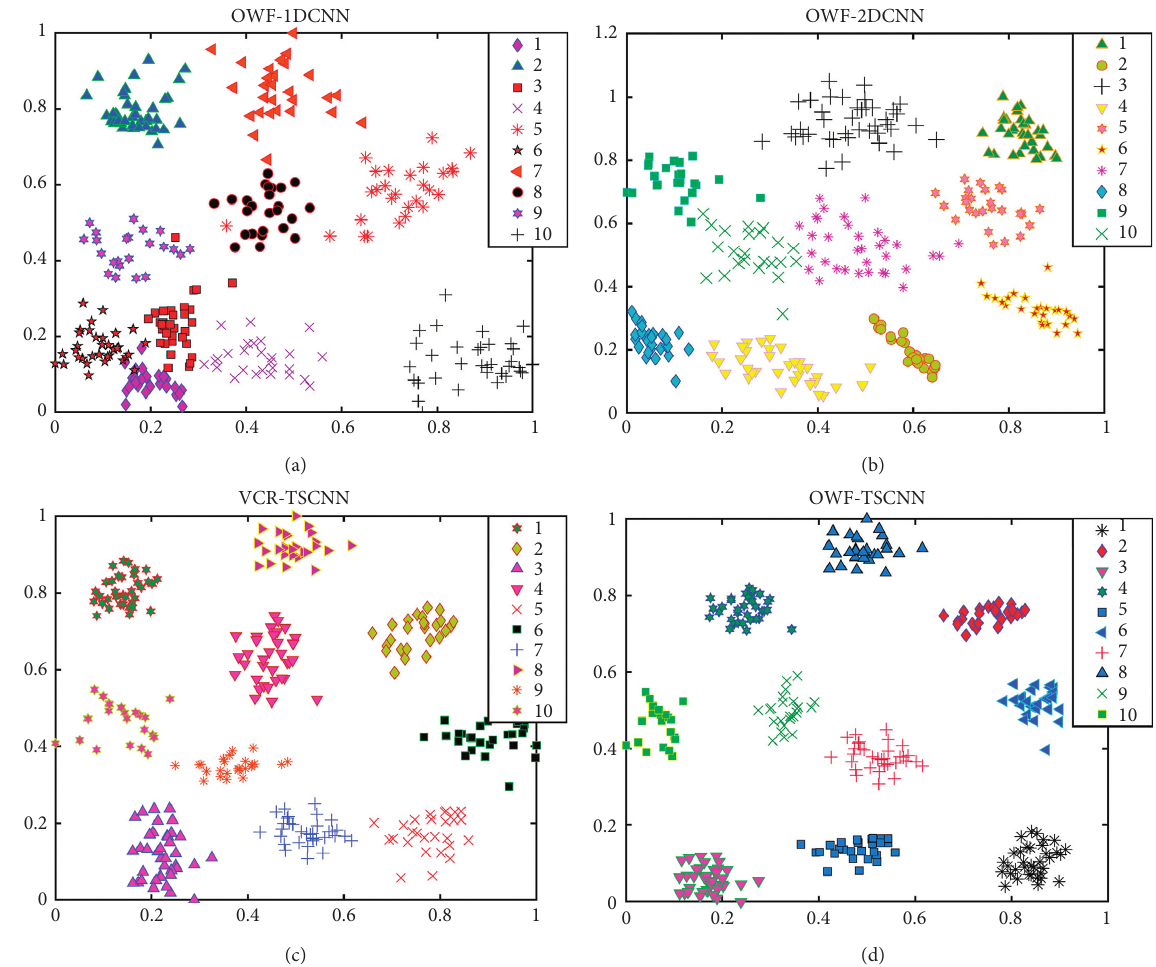
Figure 9: Feature visualization: (a) OWF-1DCNN; (b) OWF-2DCNN; (c) VCR-TSCNN; (d)